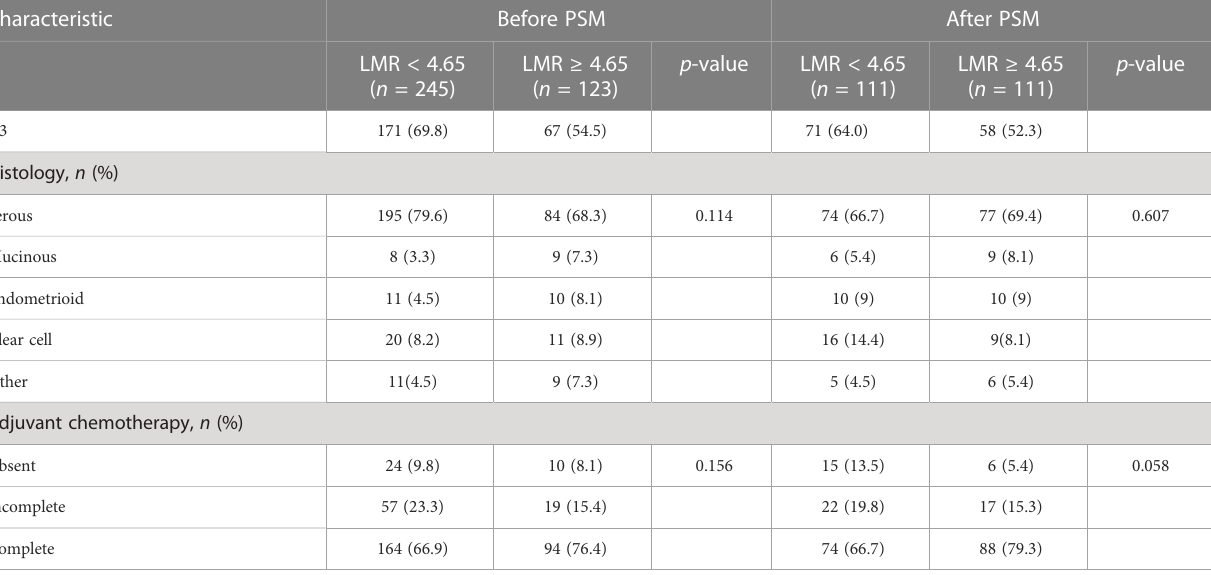
FIGO stage were independent prognostic factors. These factors were subsequently incorporated into a multivariate Cox regression analysis. As shown in Table 2, LMR was identi fi ed as a candidate risk factor (HR = 1.49, 95% CI: 1.02 – 2.18, p = 0.041). In the PSM cohort, the survival analysis further con fi rmed that patients with LMR < 4.65 had shorter OS compared with patients with LMR ≥ 4.65 ( p = 0.015, Figure 2B). The median OS of the low- and high- LMR groups was 83.3 months and 132.2 months, respectively.